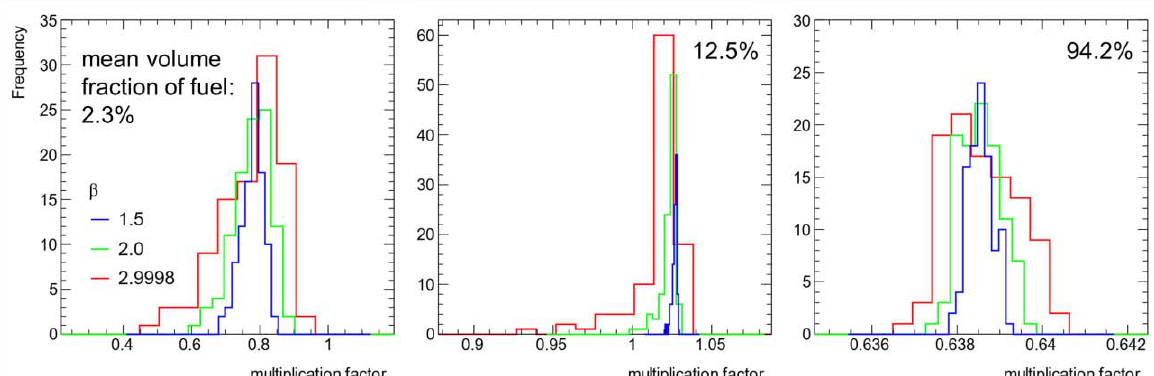
values of random media which had different β values (1.5, 2.0, and Figure 3. Histograms of the k eff 2.9998) in different mean volume fraction of fuel (2.3%, 12.5%, and 94.2%). The blue, green, and red line denote the results in the case that the β values are 1.5, 2.0, and 2.9998,